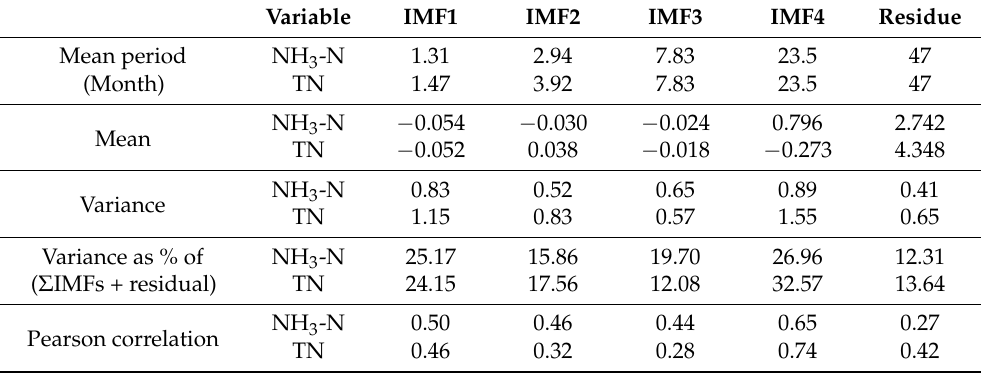
Table 3. The IMFs and the residue values for the decomposed long-term water quality data.